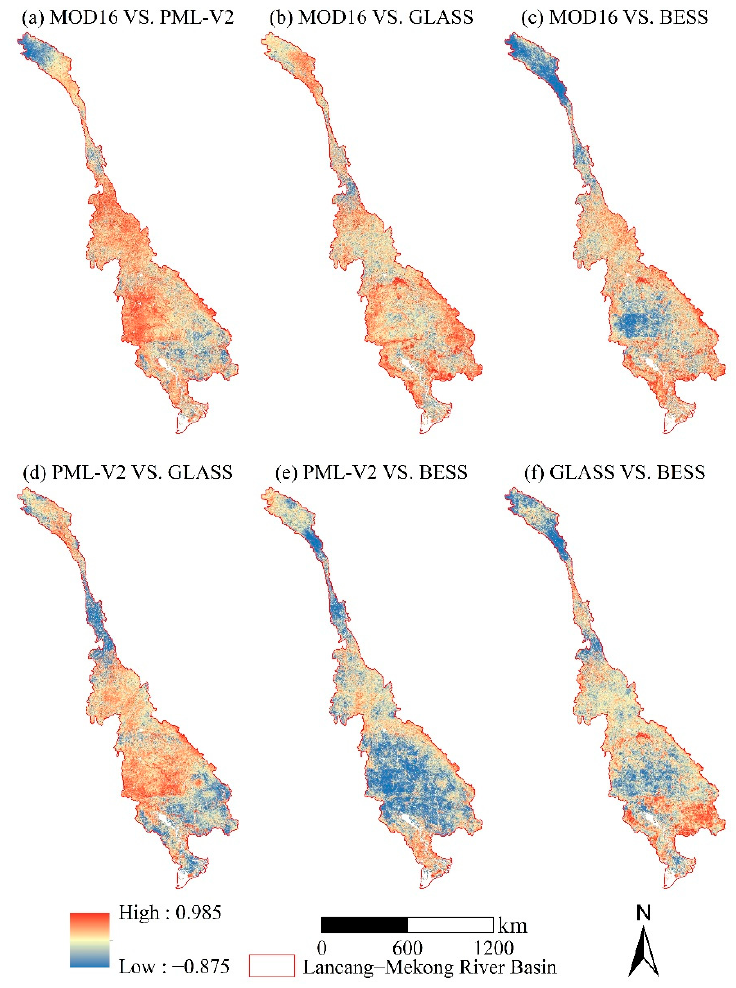
Figure 6. Spatial correlation of annual evapotranspiration between MODIS and PML-V2 ( a ), MOD16 and GLASS ( b ), MOD16 and BESS ( c ), PML-V2 and GLASS ( d ), PML-V2 and BESS ( e ), and between GLASS and BESS ( f ) over the entire basin.